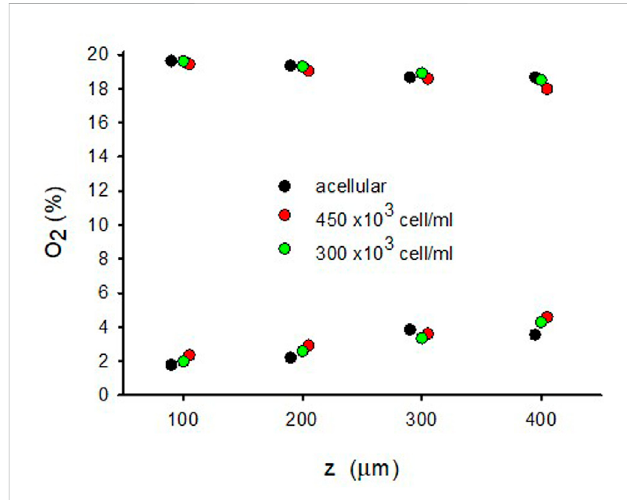
FIGURE 4 Maximum and minimum of O 2 for different positions ( z ) in the W = 500 μ m lung extracellular matrix hydrogel when the intermittent air circulating beneath the membrane was 20% O 2 for 30 s 0% O 2 for 30 s. O 2 concentration was measured in 4 different random areas (data showthemean±SDineacharea)oftwodifferenthydrogelsamples(red and blue symbols). Lines correspond to the mean corresponding to all values of z.